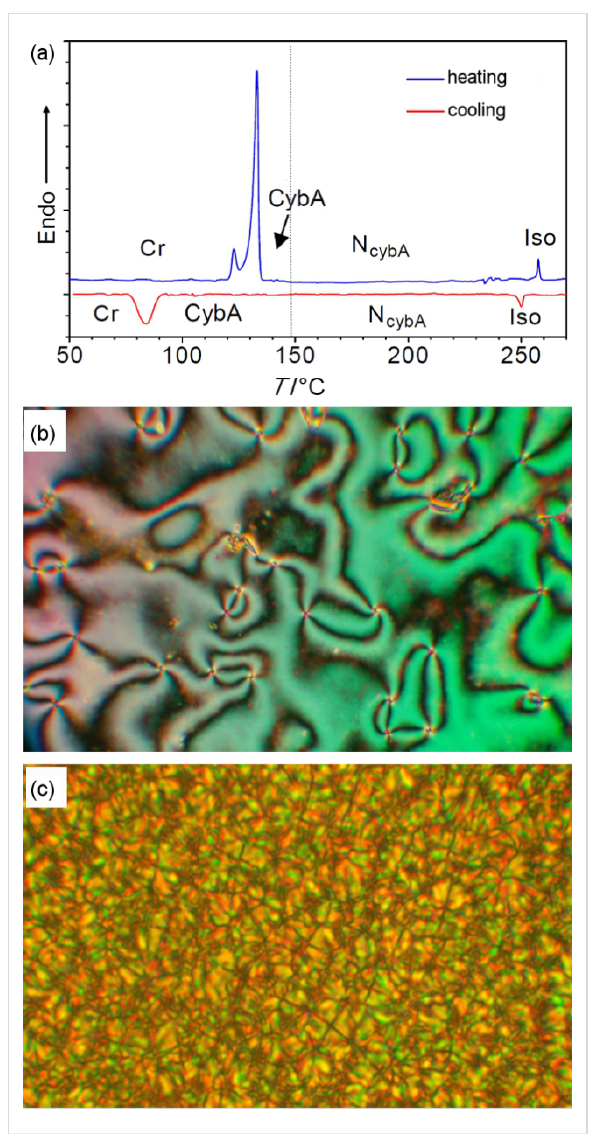
Figure 2: Dimesogen CB-Ox/4 : (a) DSC traces obtained during initial heating and cooling cycles scanned at a rate of 10 K min − 1 ; (b,c) textures as seen between crossed polarizers for a homogenously aligned sample; (b) Schlieren texture of the N cybA phase at T = 245 °C; (c) polydomain texture of the CybA phase at T = 135